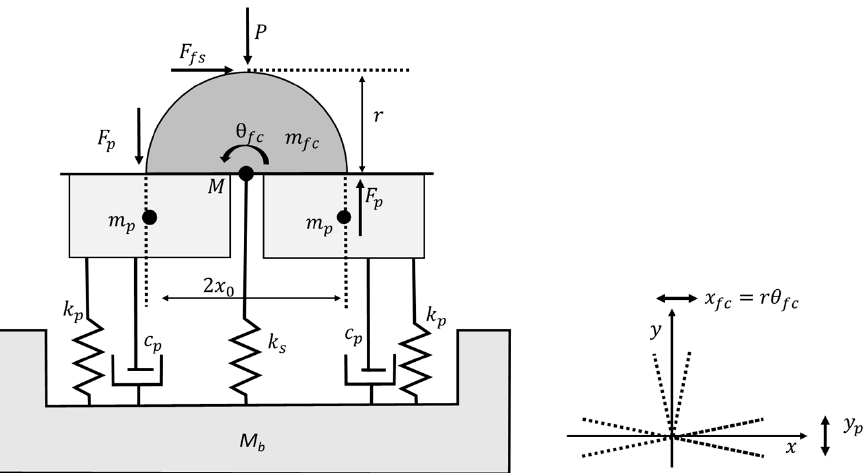
Figure 6. Kinetic model of the stator and the motion transfer from actuator shrinkage/expansion to angular deformation of the friction coupler. Distance between the center of gravity of the actuators is ( 2𝑥 (cid:2868) ). The actuator displacement ( 𝑦 (cid:3043) ) is converted into the rotational movement ( 𝑥 (cid:3033)(cid:3030) ) of the friction